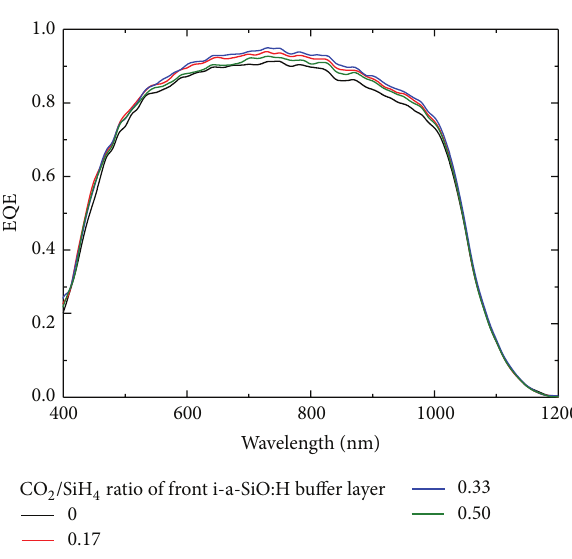
Figure 6: Spectral response as a function of the CO 2 /SiH 4 ratio for the front i-a-SiO:H buffer